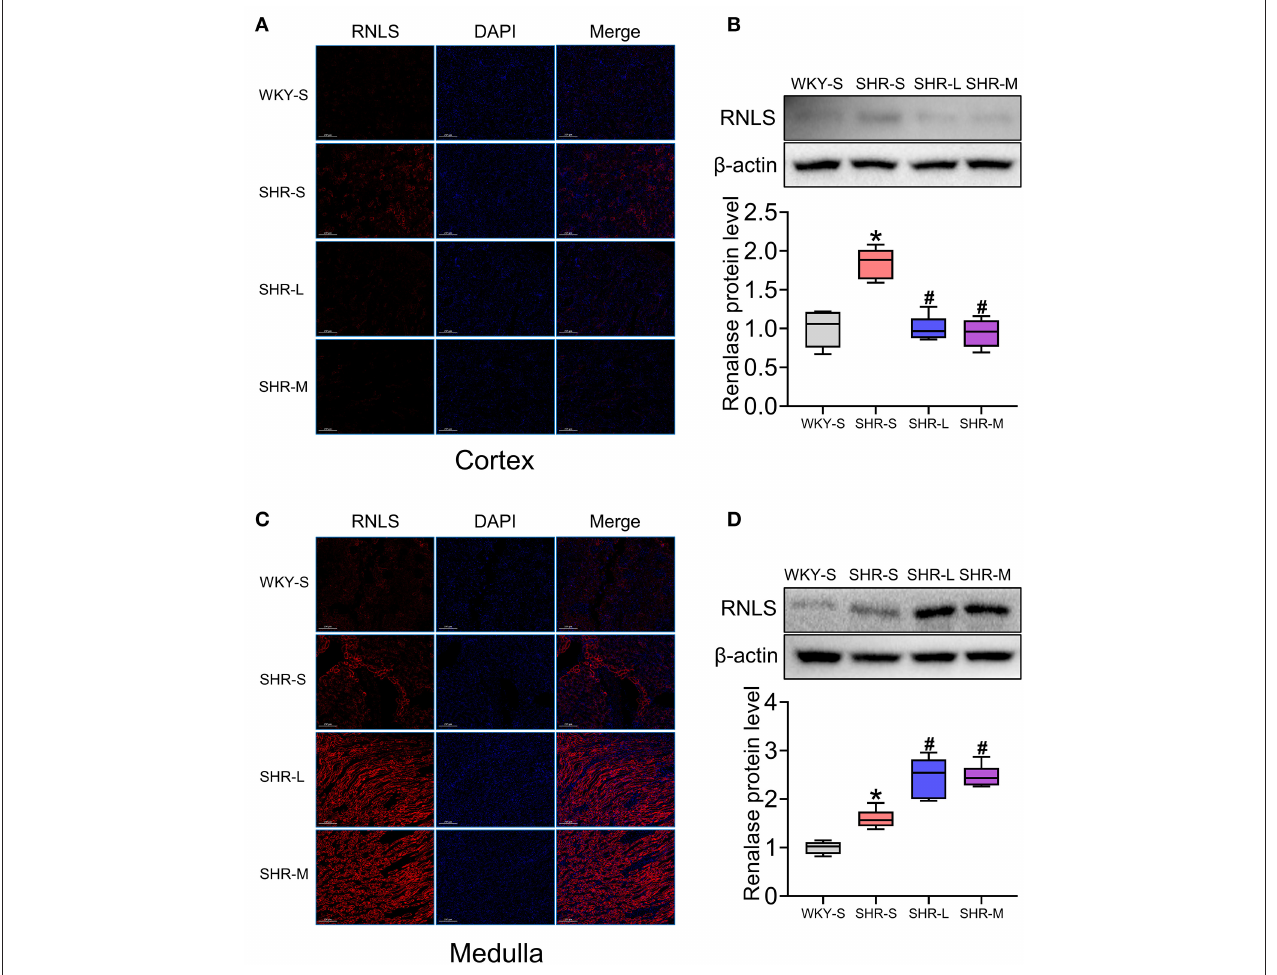
FIGURE 3 | Effect of aerobic exercise training on RNLS protein expression in kidney of SHR. RNLS expression of renal cortex and medulla were determined using immunofluorescence (A,C) and western blot (B,D) . Data are presented as Box-whisker Plot. * P < 0.05 (WKY-S vs. SHR-S), # P < 0.05 (SHR-L, SHR-M vs.